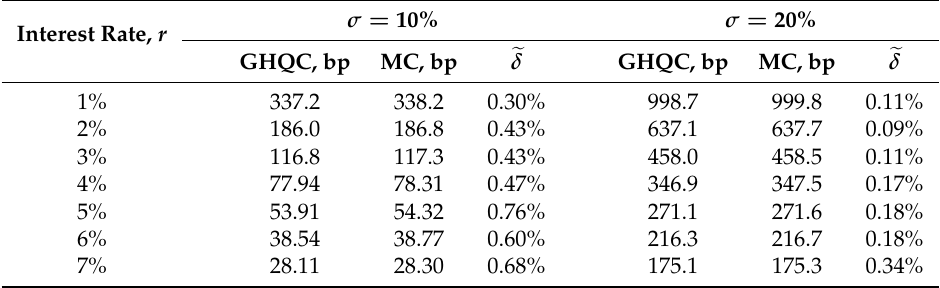
Table 1. Fair fee α in bp (1 bp = 0.01%) as a function of the interest rate r for the Guaranteed Minimum Accumulation Benefit (GMAB) rider with the annual ratchet and no withdrawal. The contract maturity is T = 10 years. (cid:101) δ is the relative difference between Monte Carlo (MC) and GHQC method results. σ = Interest Rate, r